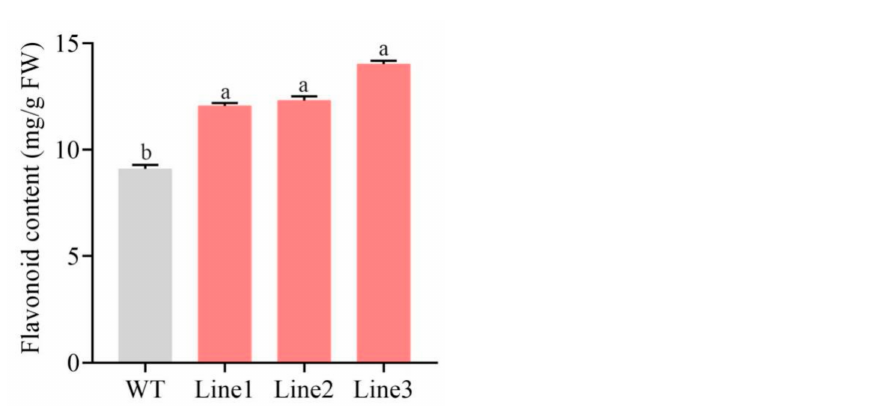
Figure 7. Flavonoid content of WT and transgenic lines under drought stress. Tobacco plants were stressed by drought for 10 days. The values represent the mean ± SD, and different letters indicate significant differences according to Duncan’s multiple range test ( p < 0.05).